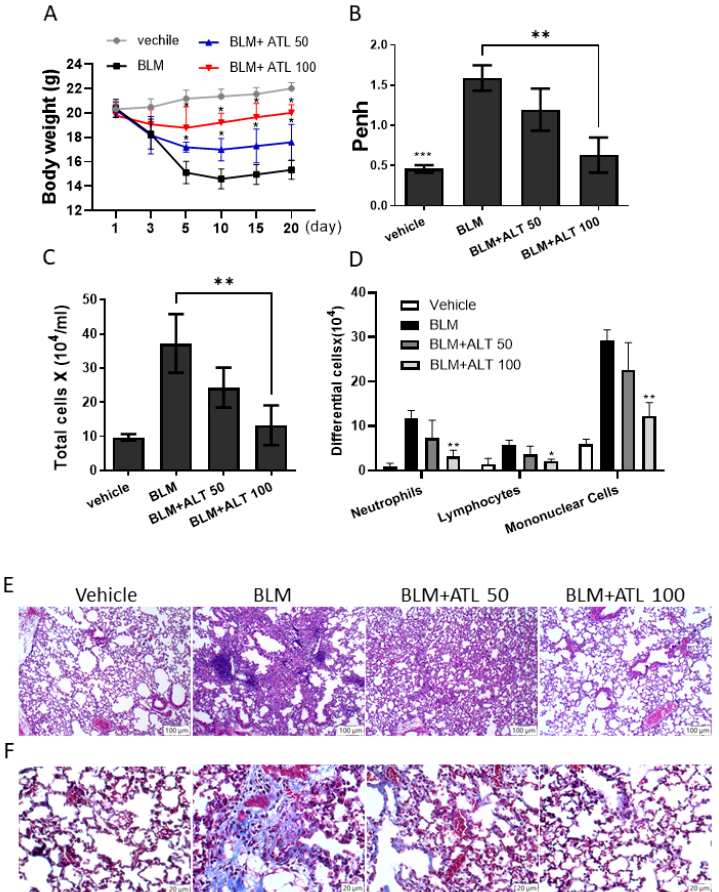
Figure 6. Atractylodin ameliorated BLM-induced pulmonary fibrosis. ( A ) The body weight changes in BLM-treated mice received ATL treatment 0, 50, and 100 mg/kg. ( B ) The lung function test for Penh value was performed by plethysmograph on day 21. ( C ) Numbers of total inflammatory cells and ( D ) immune cells of neutrophils, lymphocytes as well as mononuclear cells in BALF were stained with Wright-Giemsa stain and counted under the microscopy. Data are expressed as mean ± SEM of five mice in each group. (*) p < 0.05, (**) p < 0.01, (***) p < 0.001 versus vehicle-treated BLM model group (as control group), as determined by non-parametric Kruskal–Wallis test and all pairwise multiple comparison procedures (Dunn’s Method). ( E ) Pulmonary pathological changes in tissues from BLM treated mice with or without ATL treatments were examined followed by H&E staining (original magnifications, 400 × ). ( F ) Collagen deposition in lung tissues was visualized and examined by Masson’s trichrome staining (original magnifications, 400 ×